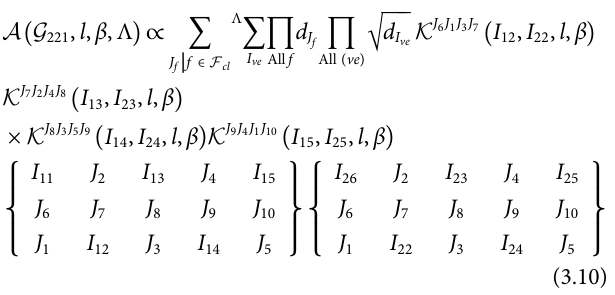
FIGURE 2 | The quartic tensorial bubble interaction B 41